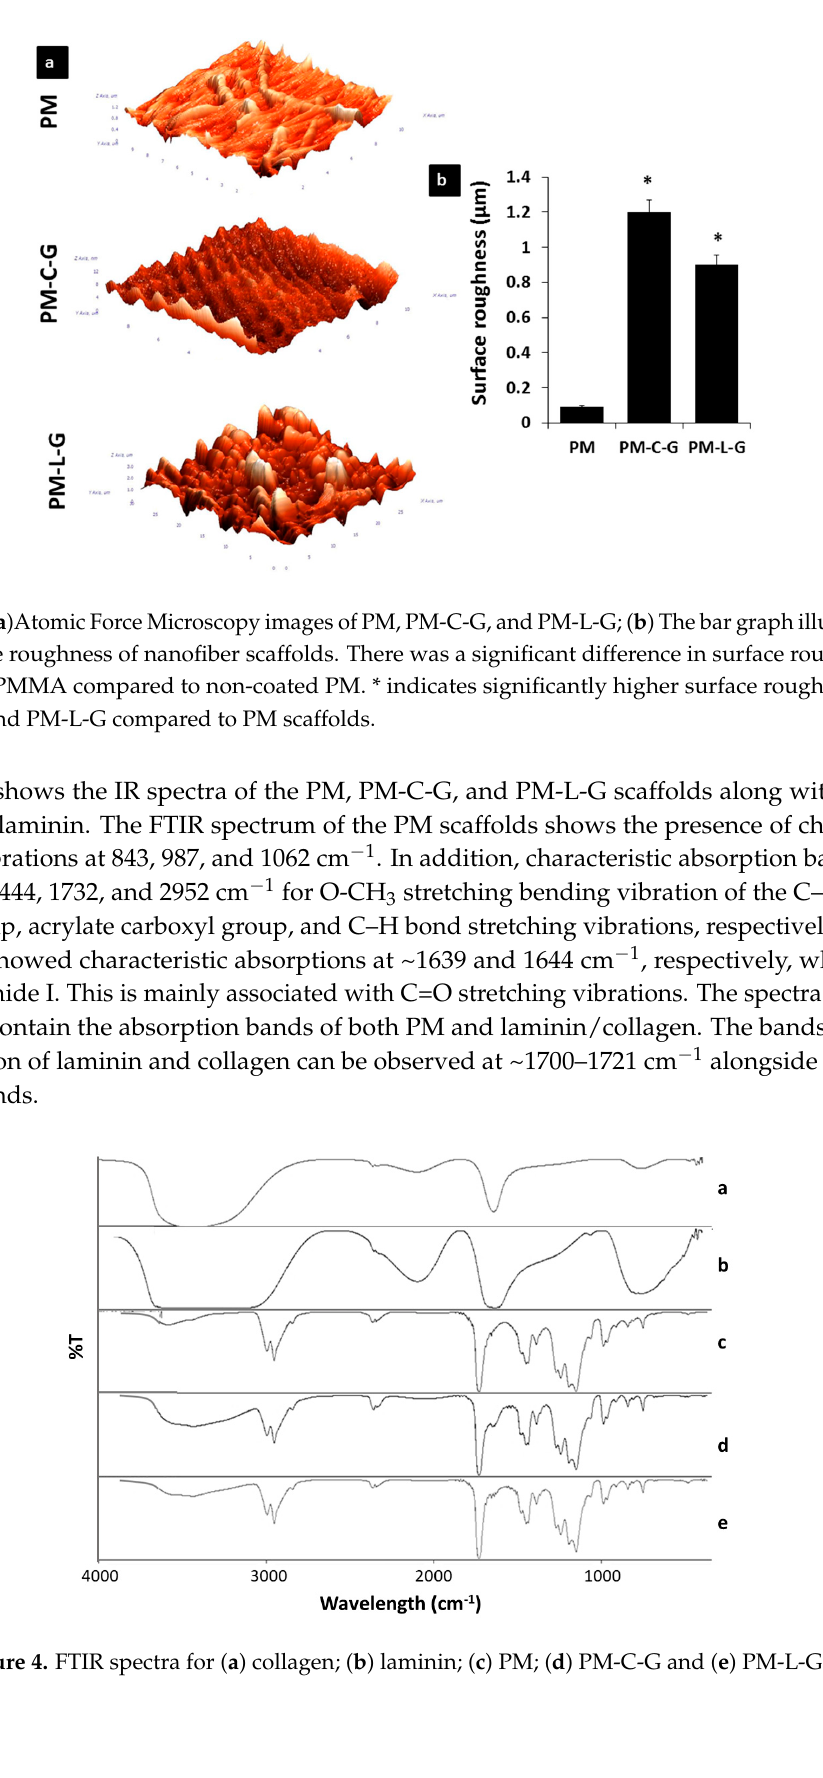
Figure 4. FTIR spectra for ( a ) collagen; ( b ) laminin; ( c ) PM; ( d ) PM-C-G and ( e ) PM-L-G.